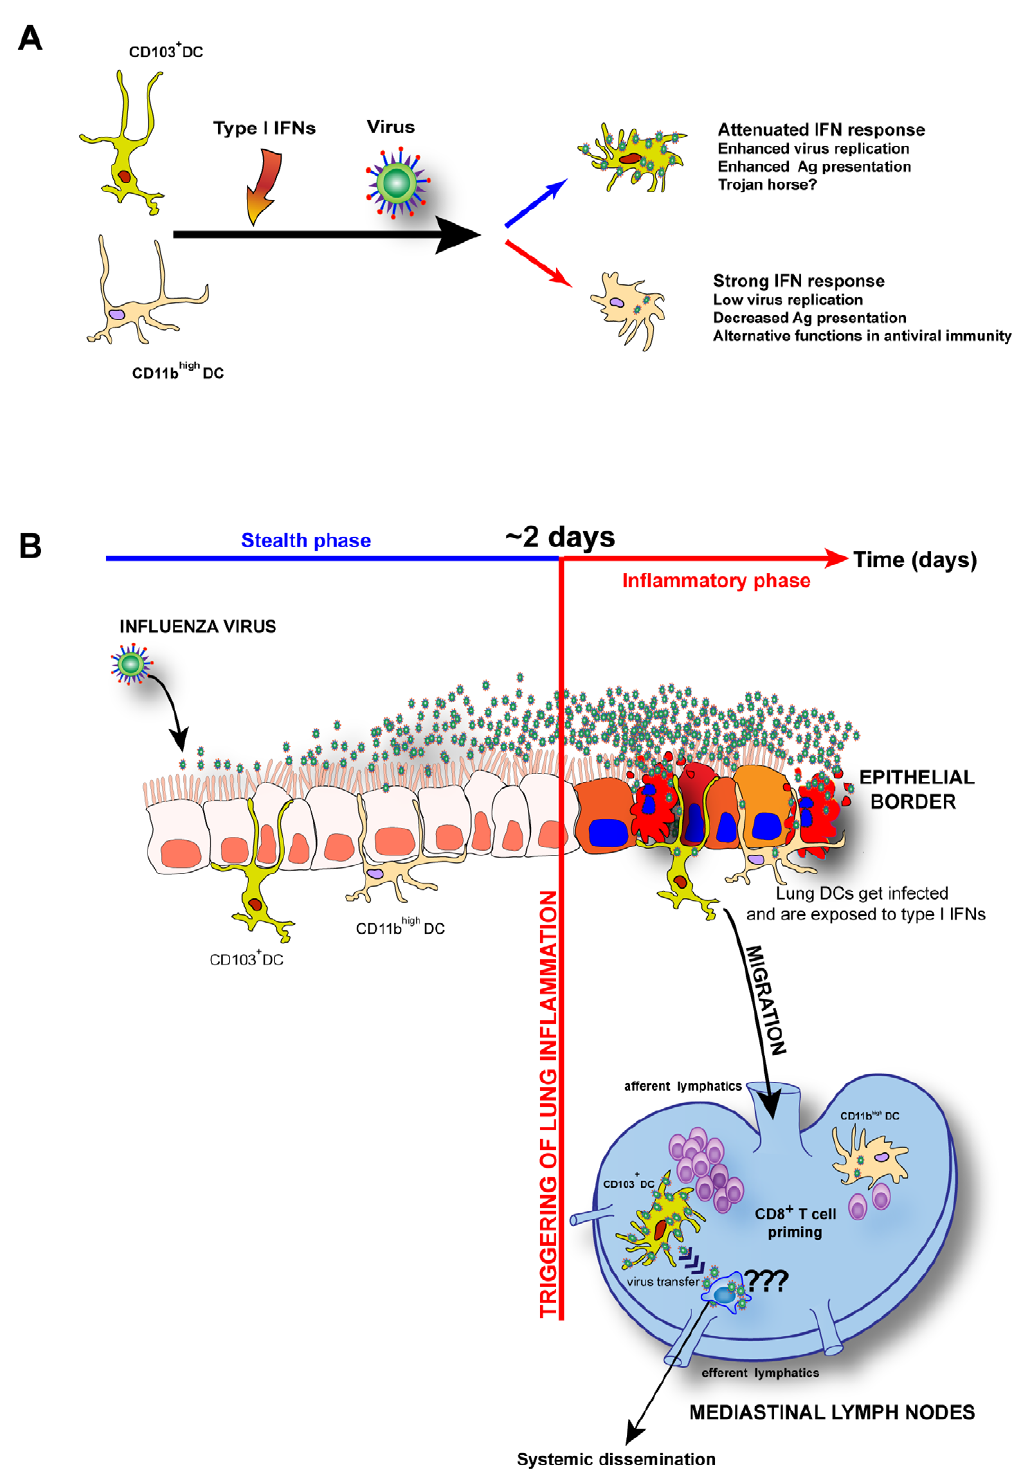
Figure 7. Model: Unique I-IFNs responses determine the functional fate of migratory lung DCs during respiratory virus infection. A. CD103 + DCs are naturally resistant to IFNAR signaling and allow virus replication to higher levels leading to enhanced antigen presentation, when compared to CD11b high DCs that respond strongly to I-IFNs and impede virus replication and Ag presentation. B. The in vivo implications of virus infection and unique IFNAR signaling by CD103 + DCs and CD11b high DCs during influenza virus infection and other respiratory viruses. Both lung DCs begin to migrate to the MLNs when lung inflammation is initiated around 2 days post-infection, an event that is preceded by unabated virus replication without an apparent innate response (stealth phase). IFNAR signaling is not protective in CD103 + DCs and their inherent susceptibility to virus infection may make them function as ‘‘Trojan horses’’ that transfer virus to other leukocytes in the MLNs and upon exit through efferent lymphatics disseminate virus systemically.